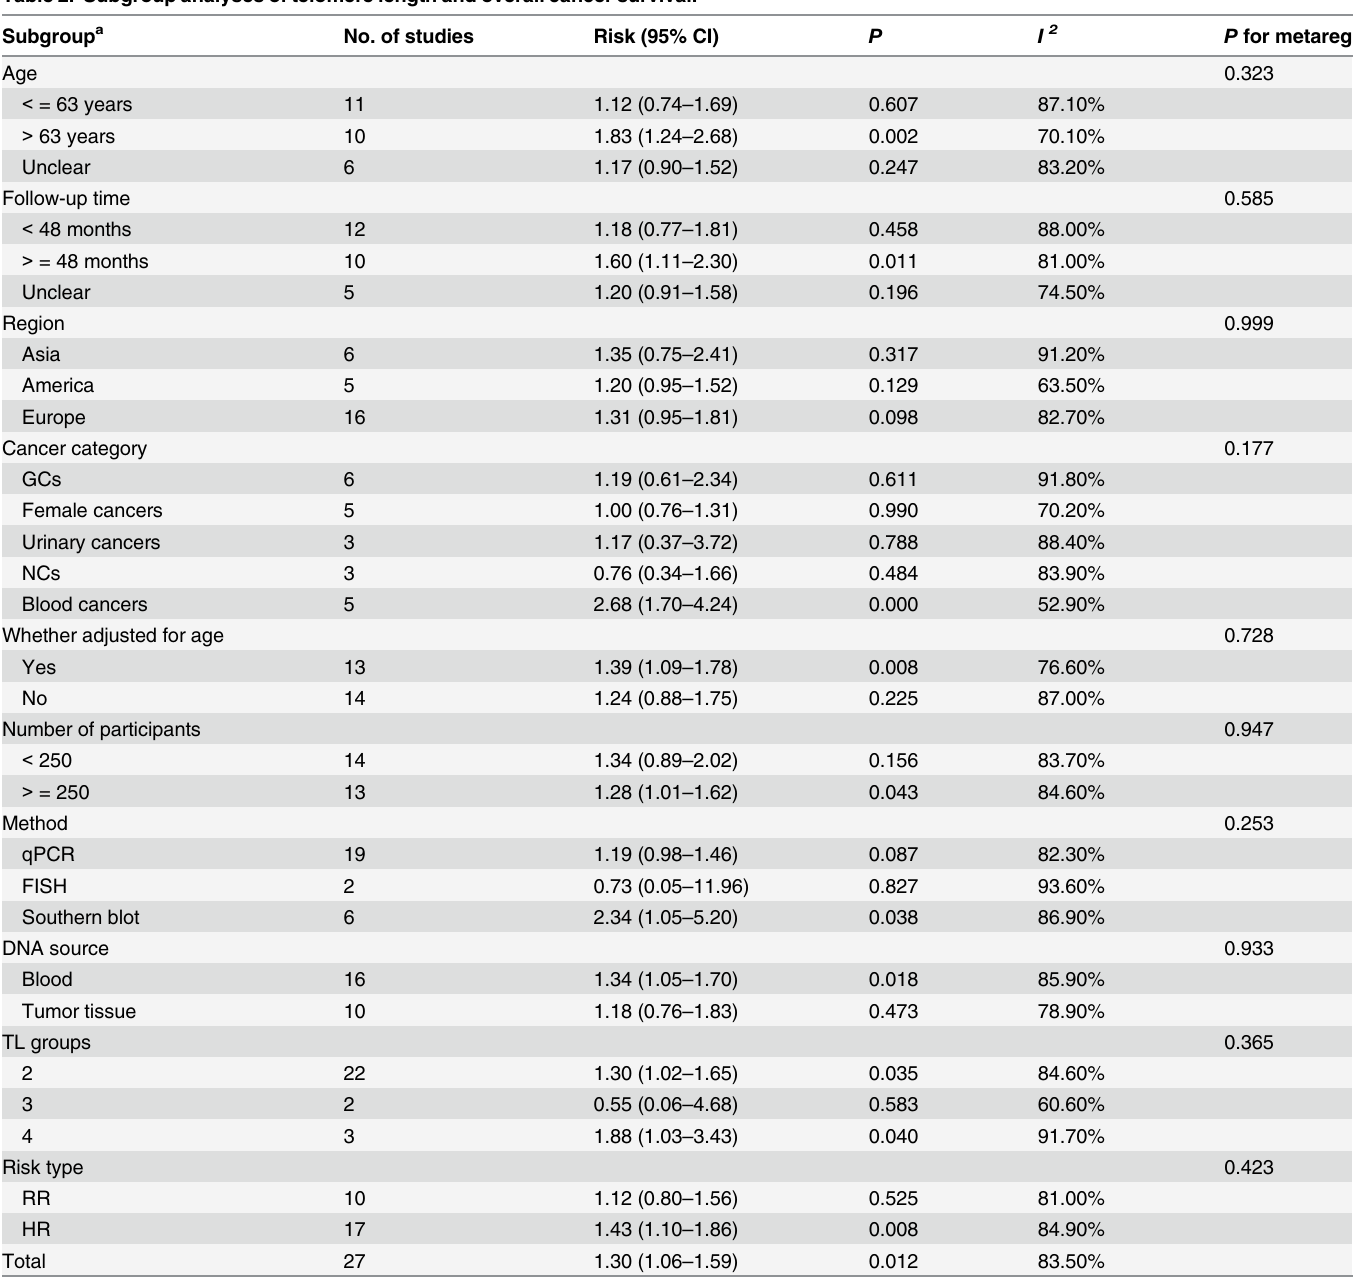
Table 2. Subgroup analyses of telomere length and overall cancer